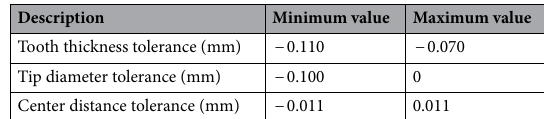
Table 4. Manufacturing errors of gear